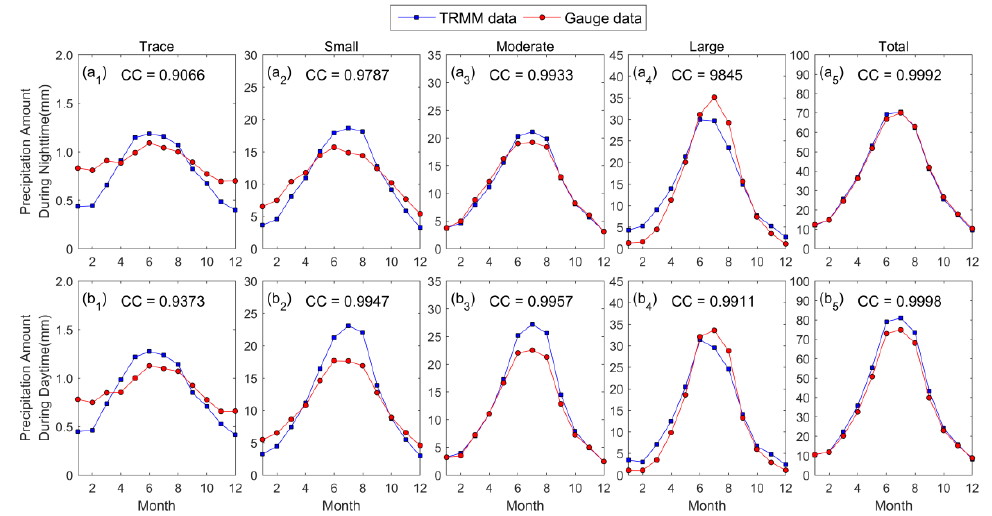
Figure 7. As in Figure 5, but for the amount of precipitation. The y -axis scales are different for different precipitation categories.